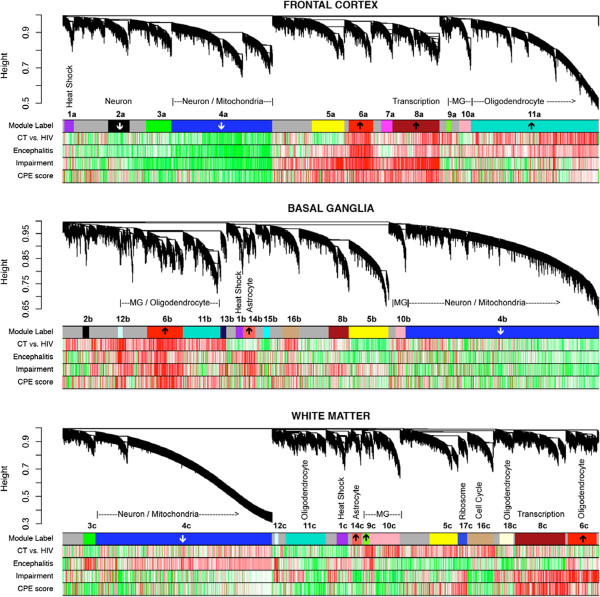
Co-expressed genes tend to cluster into modules corresponding to major biological divisions (cell type, molecular function, etc.), as well as disease-relevant changes. Module summaries are presented for frontal cortex (top), neostriatum (middle), and white matter (bottom). The dendrograms group genes into distinct modules using hierarchical clustering. The y-axis corresponds to distance determined by the extent of topological overlap (1-TO). Top color band (Module label): dynamic tree cutting was used to identify highly parsimonious module definitions, generally dividing modules at significant branch points in the dendrogram. Second color band (CT vs. HIV): plotted T values of control vs. HIV + samples. Third color band (Encephalitis): plotted T values of HIV without encephalitis (groups B,C) vs. HIV with encephalitis (group D) samples. Fourth color band (Impairment): plotted correlations of GCR scores, our measure of neurocognitive impairment, across all HIV subjects. Fifth color band (CPE score): plotted correlations of CPE scores across all HIV subjects. Red corresponds to genes with higher expression in HIV, impairment score (GCR), HIVE, and CPE score for color bands two through five, respectively. Note that the most significant correlations with disease tend to occur in FC. Arrows within top color band indicates that these modules are enriched for genes showing increased or decreased expression in hippocampus of Alzheimer’s disease (Blalock et al. 2004; p < 0.00002).